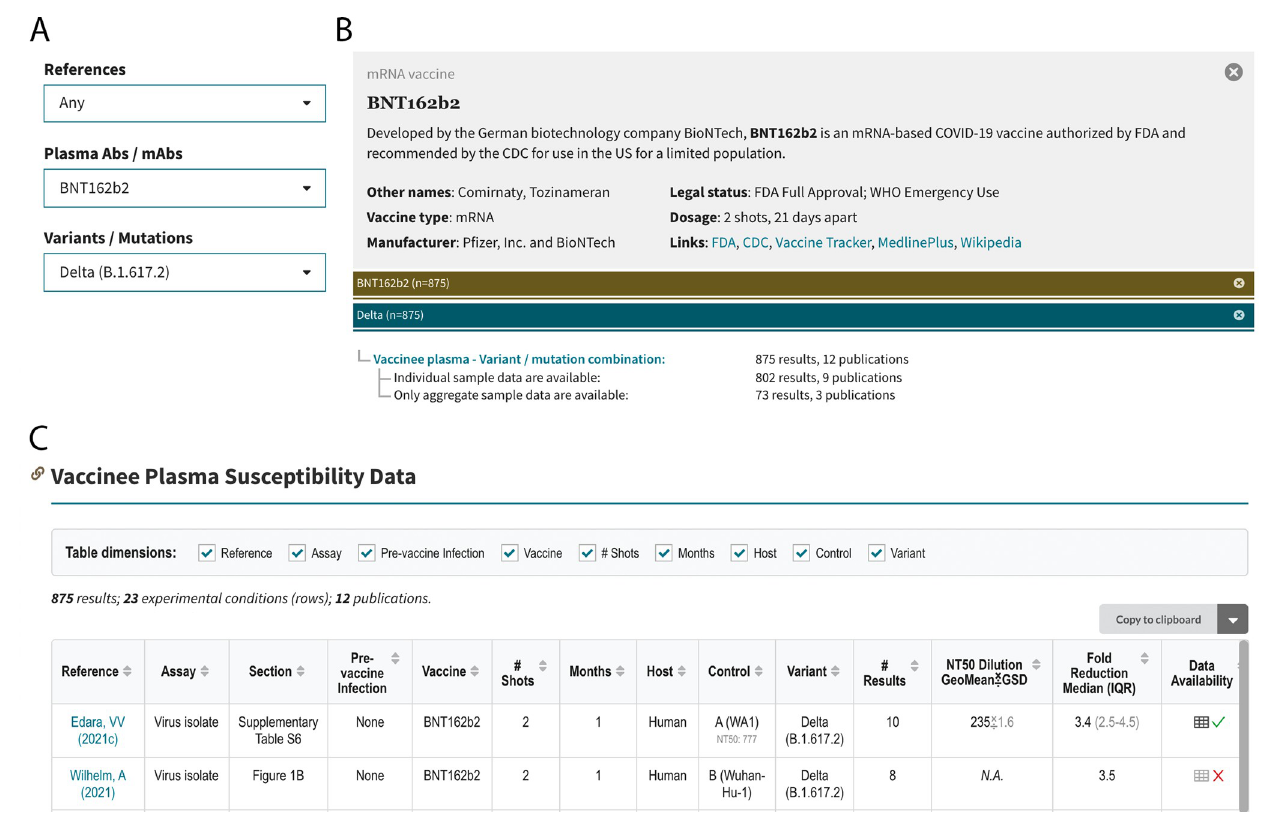
Fig 4. Query interface, sample query, and outline of query results for an example query for the susceptibility of the SARS-CoV-2 Delta variant to the vaccinee plasma (VP) of persons who received the BNT162b2 vaccine. The query interface containing three dropdown boxes is shown at the upper left (A). BNT162b2 is selected from the “Plasma / mAbs” dropdown box, and the Delta variant is selected from the “Variants / Mutations” dropdown box. The upper right summarizes the data returned by the query, which in this case includes 875 results from 12 publications (B). The summary distinguishes between results for which only aggregate (mean or median) data are provided and results for which individual data are provided. The section below the header shows the header and first few rows of the table entitled “Vaccinee Plasma Susceptibility Data” (C). The figure was modified from a screenshot captured in October 2021. The updated and complete contents of this table can be found on the web (https://covdb.stanford.edu/search-drdb/?host=human&vaccine=